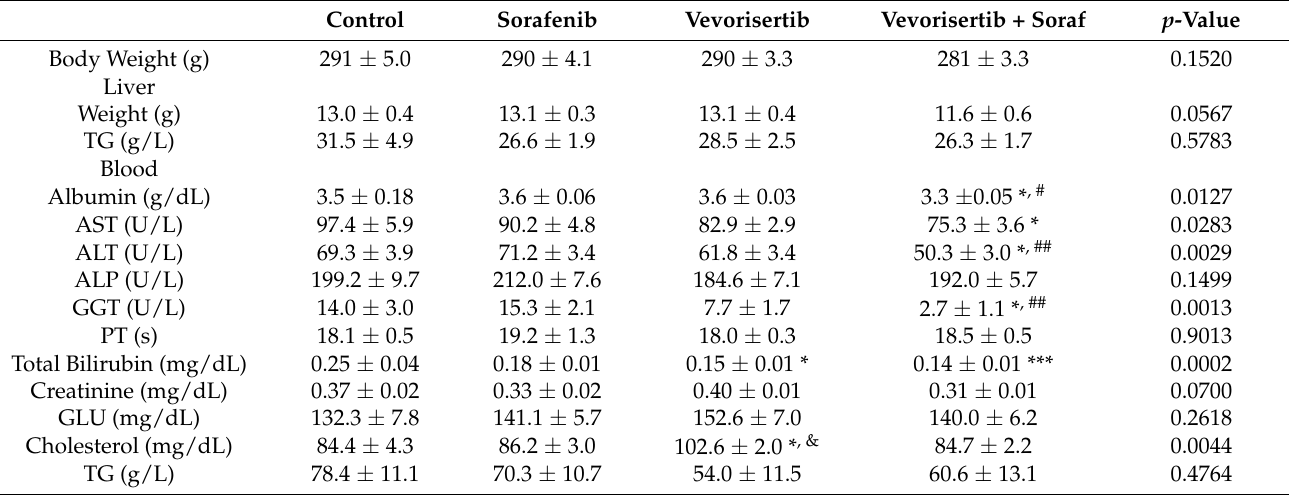
Table 1. Clinical and biological analysis.